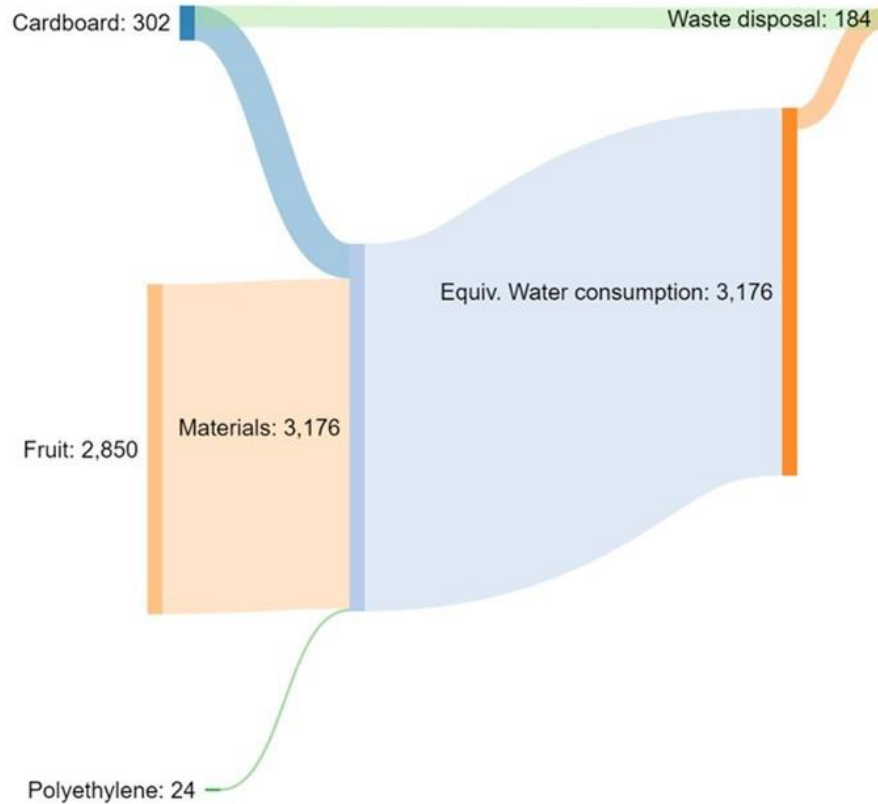
Figure 6. Water consumption for 100 kg of greenhouse tomatoes per life cycle stage (in L).